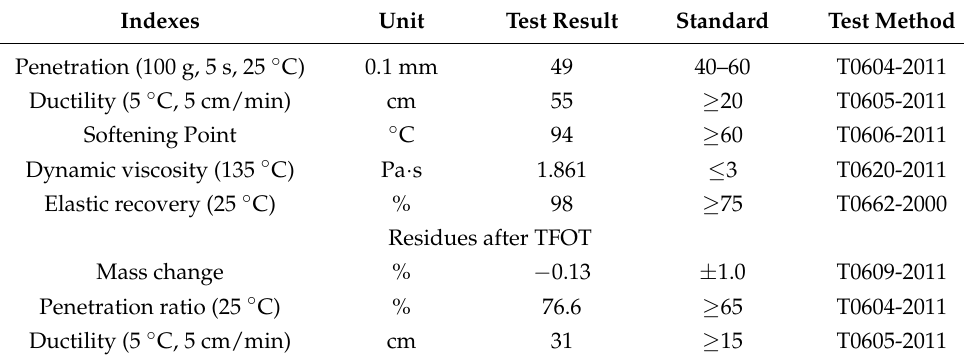
Table 5. Basic indicators of